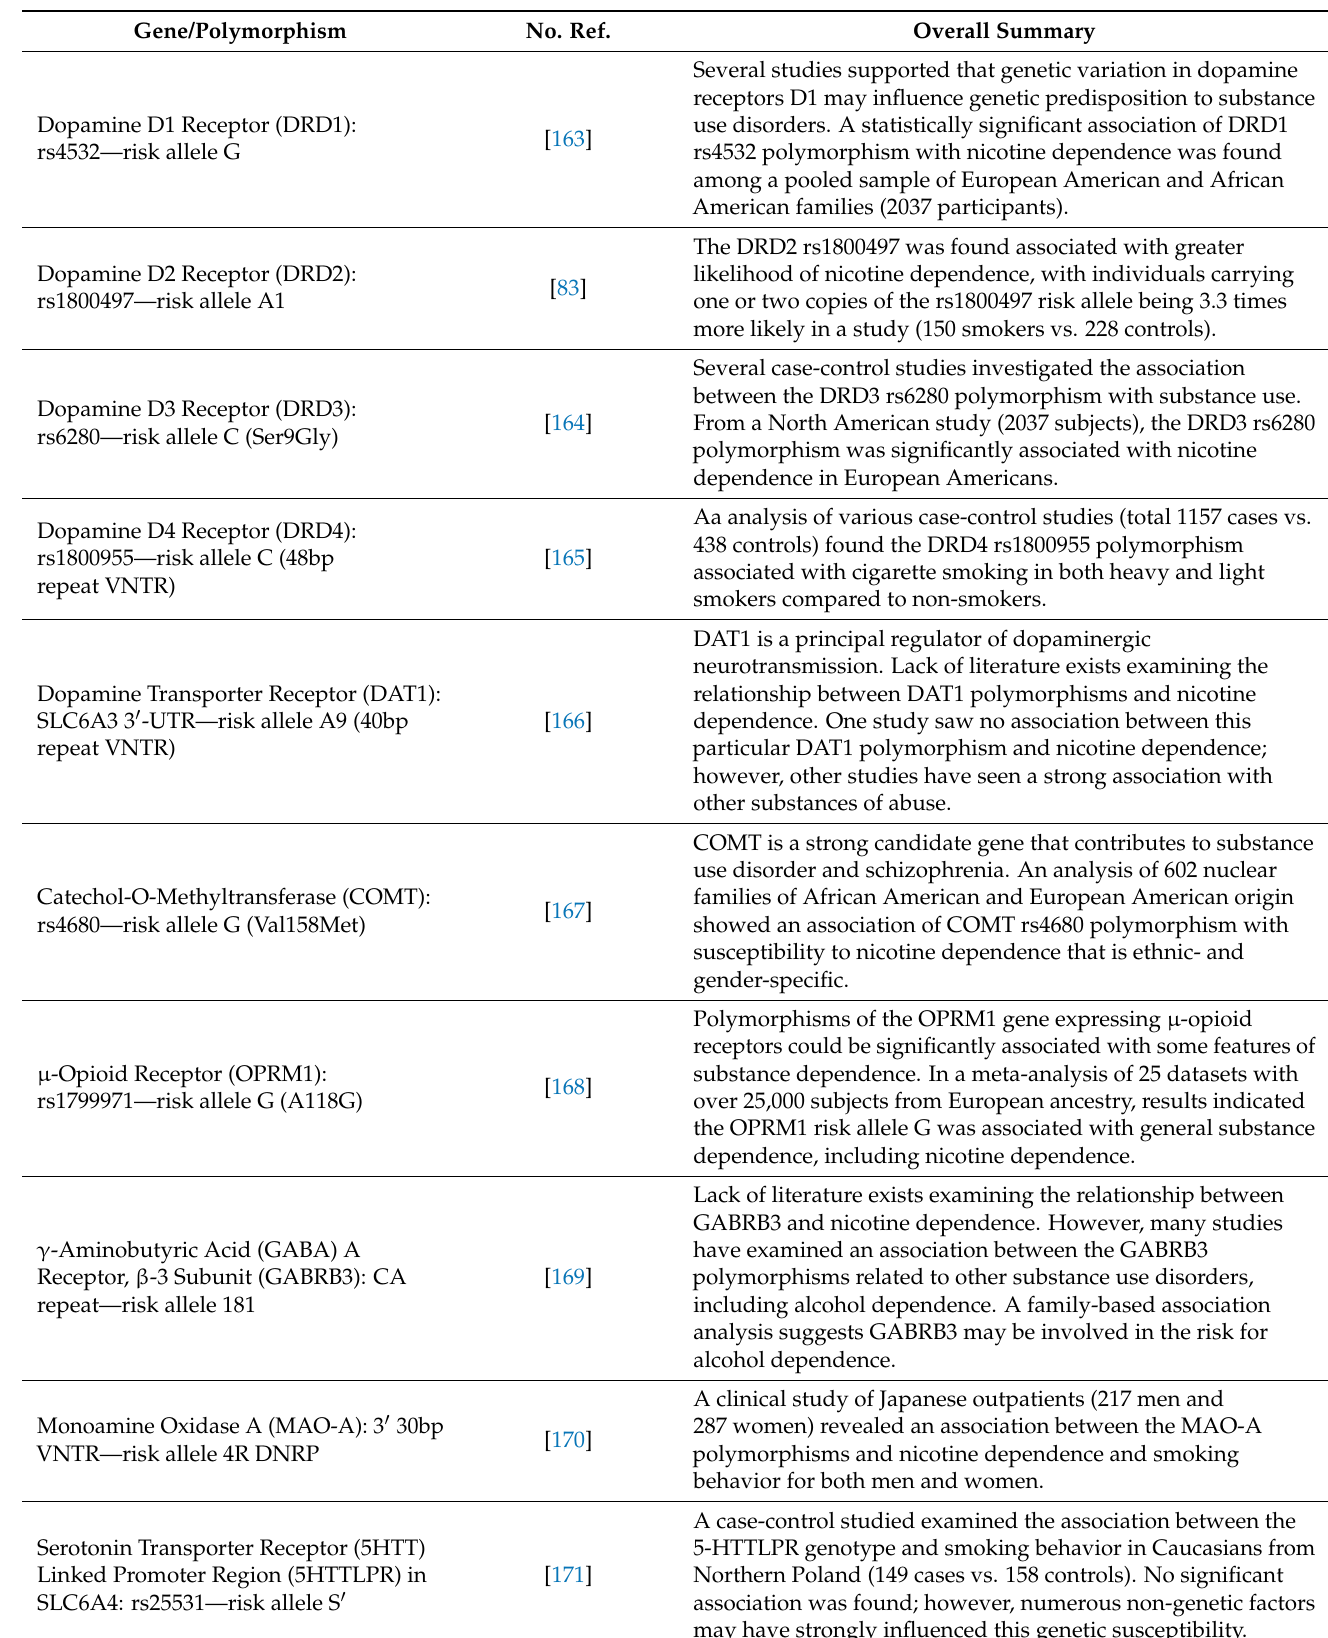
Table 1. Gene polymorphisms under consideration and the literature